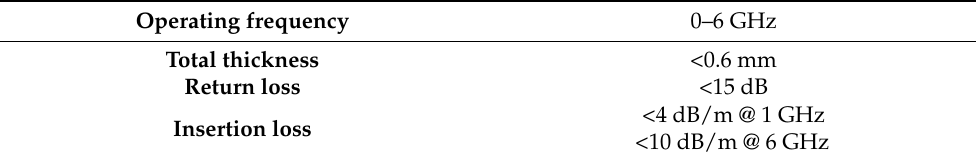
Table 2. Target specifications.